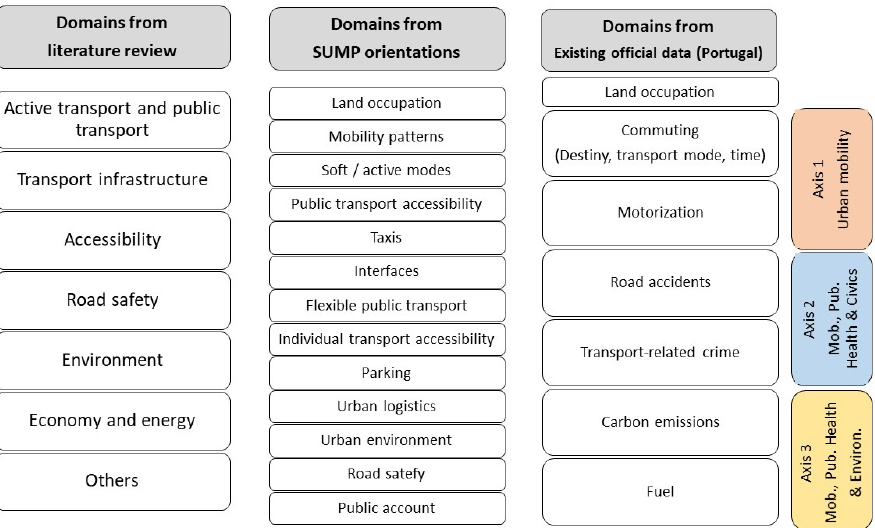
Figure 2. Domains of urban mobility (literature review, Sustainable Urban Mobility Plans (SUMP) orientations, official data in Portugal).